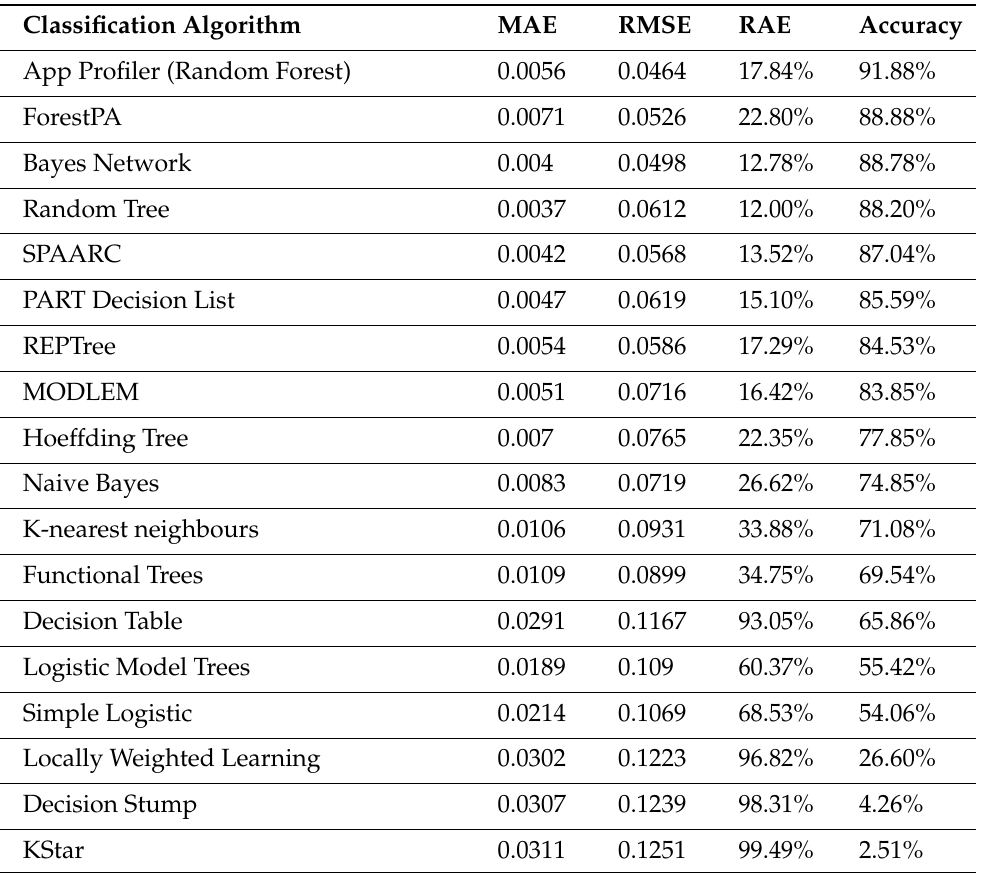
Figure 1. Application profiler conceptual architecture of the profiling and classification process. Table 1. List of classification algorithm error metrics and